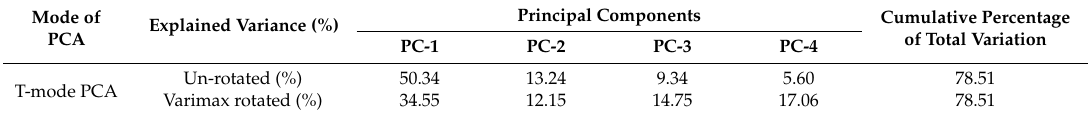
Table 4. Explained variance (%) by the loadings with and without rotation for total annual